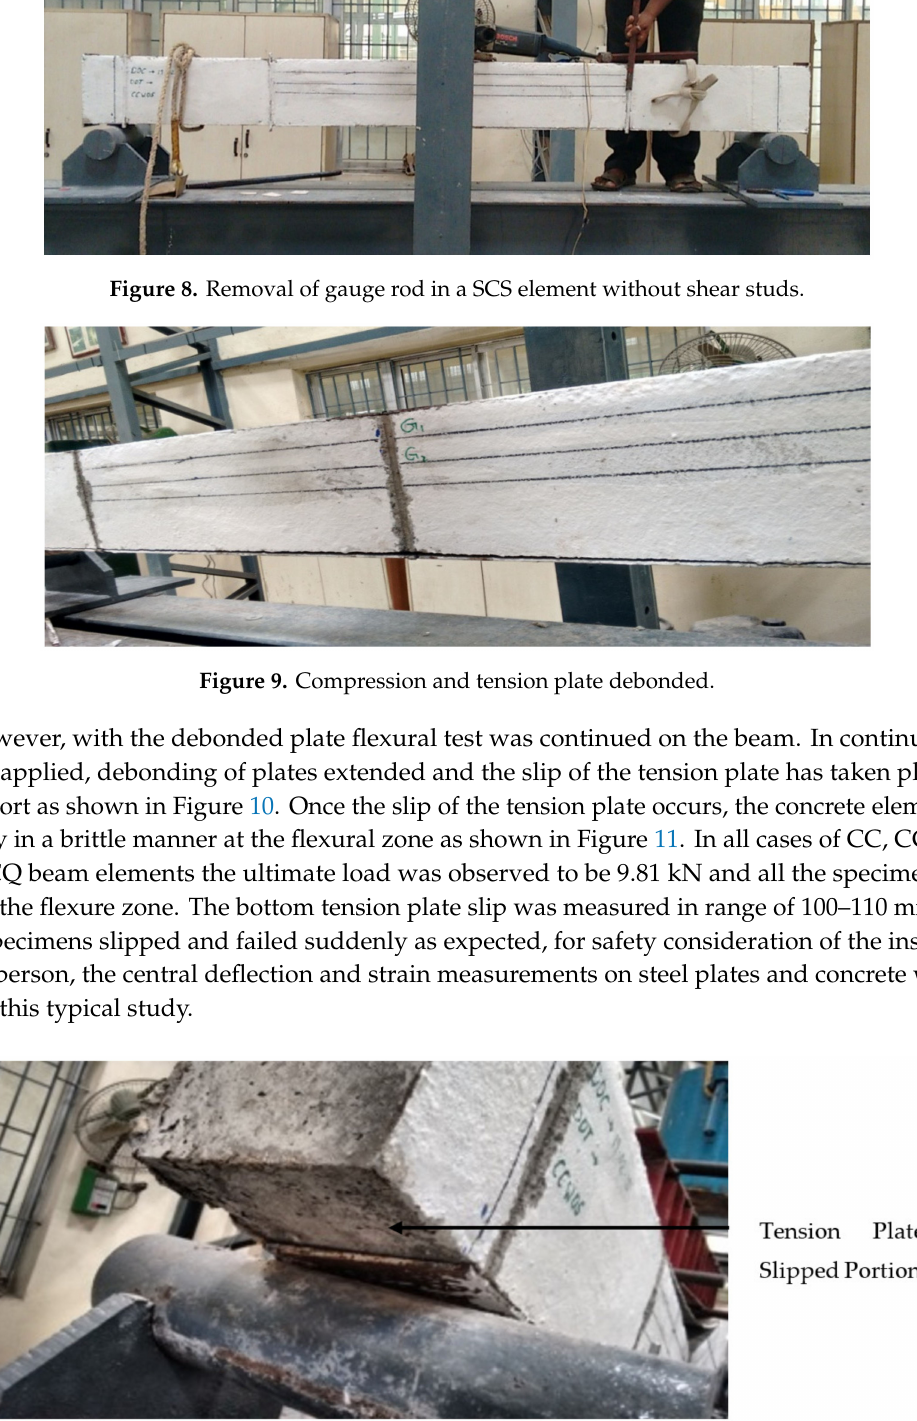
Figure 10. Slip of tension plate near the